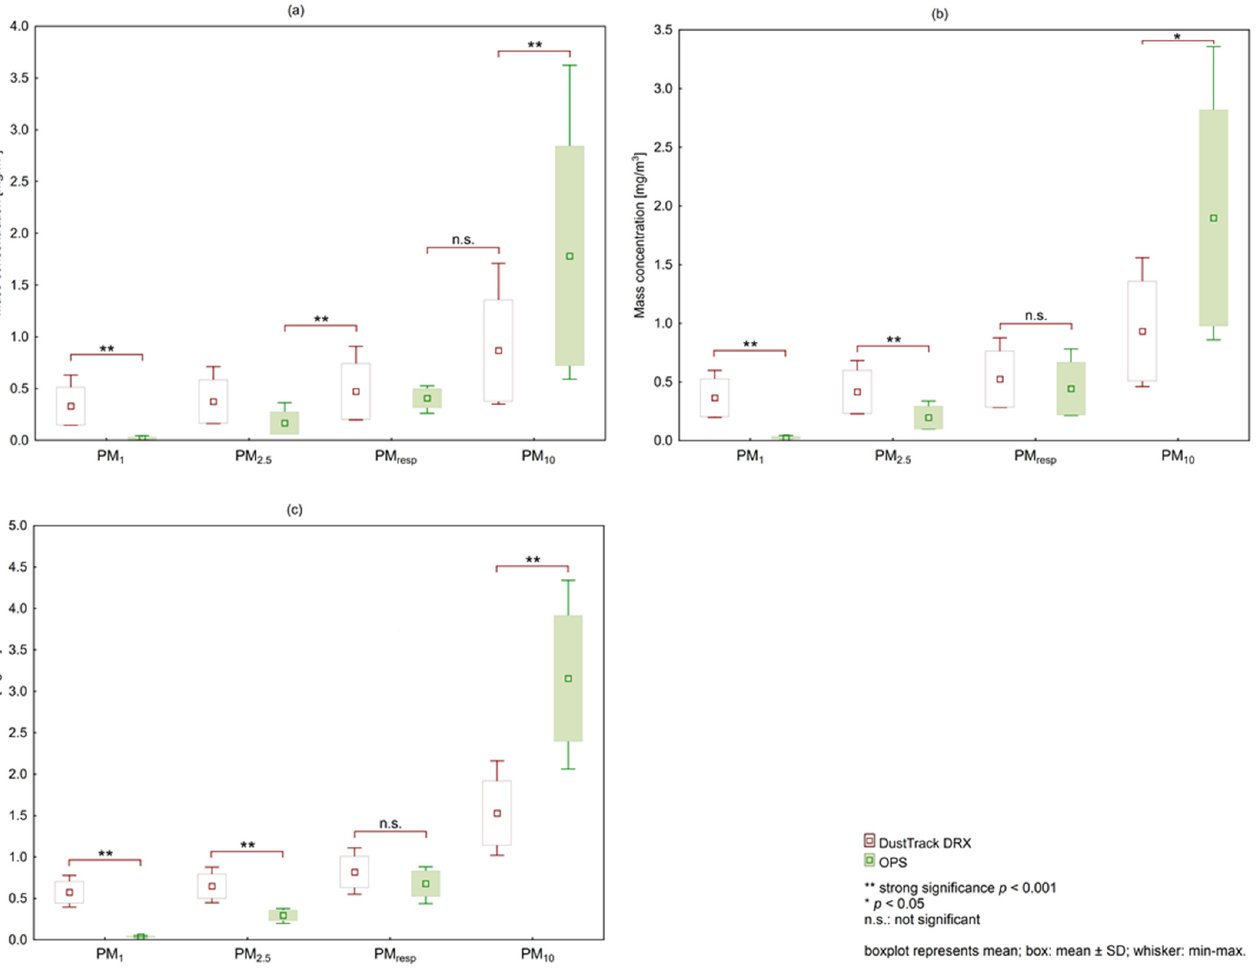
Figure 5. PM mass concentration measured by OPS and DustTrak DRX, and paired t test comparison of particle mass generated by sanding paper grits: ( a ) P60; ( b ) P120; ( c ) P240.